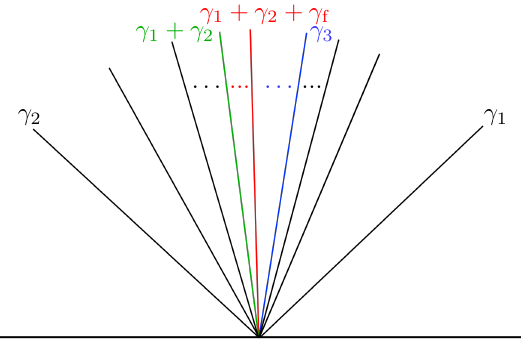
= 2 ∗ spectrum after the perturbation (5.1). The rays of N